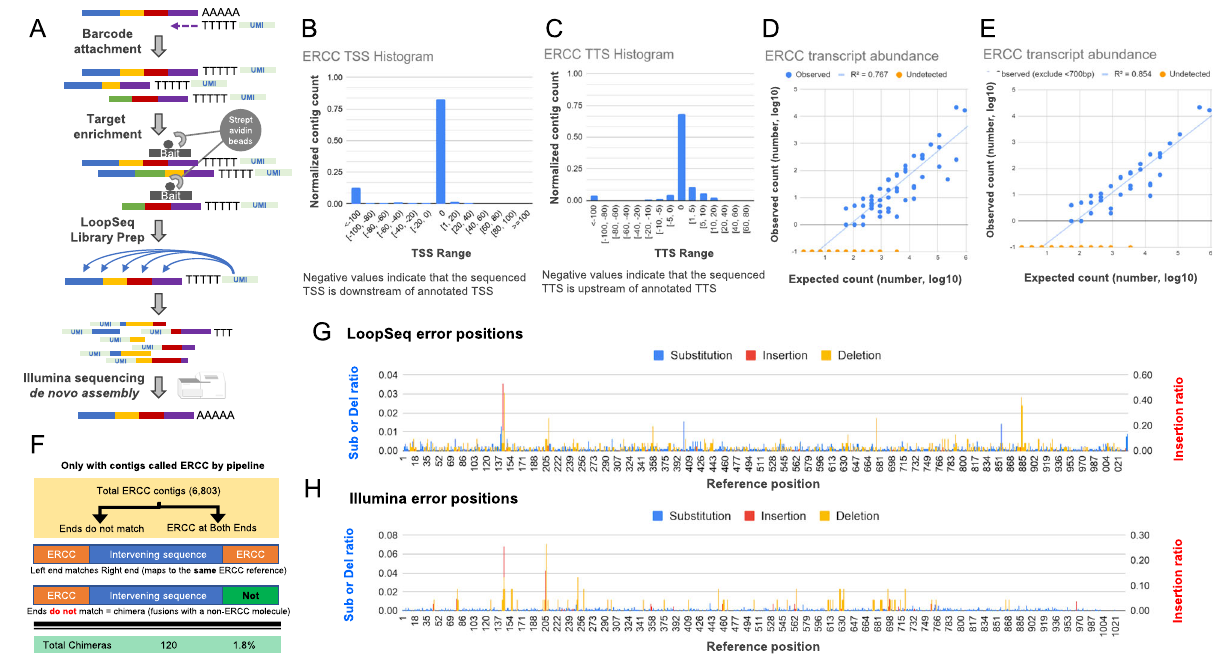
Fig. 1 Schematics and validation of LoopSeq long-read transcriptome sequencing. A Overview of the library preparation for isoform sequencing using LoopSeq, including an optional target enrichment step to focus the sequencing depth on genes or isoforms of interest. B The transcription start site (TSS) of reconstructed ERCC contigs as compared to the reference annotation. C The transcription termination site (TTS) of reconstructed ERCC contigs as compared to the reference annotation. D Comparison of ERCC transcript counts between the observed abundance as determined by reconstructed contigs and the expected abundance given the input into the library preparation. E Comparison of ERCC transcript counts between the observed and the expected abundance, excluding references <700 bp. F Overview of the chimera contig detection. Demonstration of: G the positional bias of LoopSeq errors along an ERCC reference and H the positional bias of Illumina short-read errors along the same ERCC reference. The ratio of substitution (left axis), deletion (left axis), and insertion errors (right axis) against the position on ERCC-0002 reference are shown. The plotted values are the ratio of each error at a given reference position normalized by the overall error rate of a given error type. The Illumina short-reads used for error analysis are obtained from previously published data 64